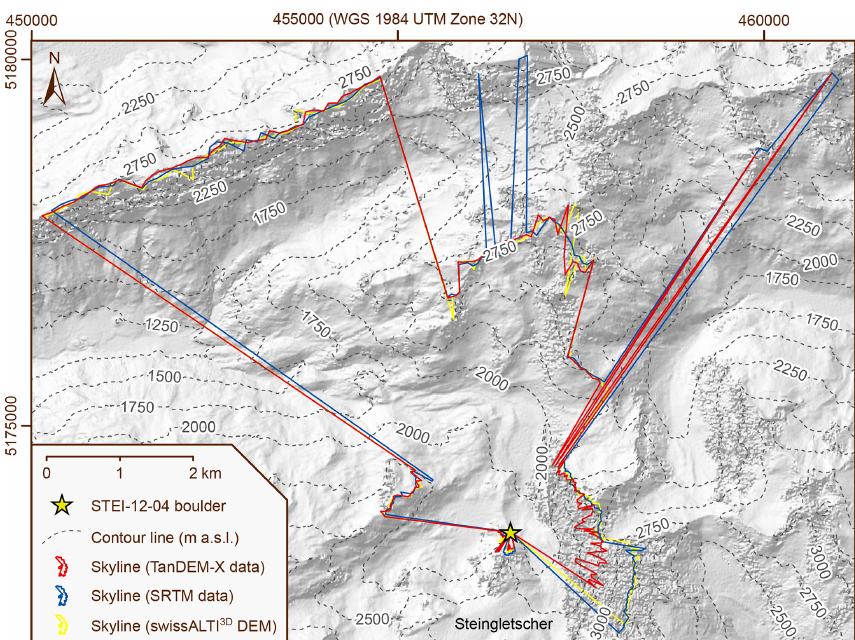
Figure 9. Skylines for the STEI-12-04 boulder in the forefield of Steingletscher derived from TanDEM-X data, SRTM data and the swissALTI 3D DEM. The skylines were superimposed on a hillshade derived from TanDEM-X data (© DLR 2021). The contour lines are based on a resampled version of the swissALTI 3D DEM ( x – y resolution: